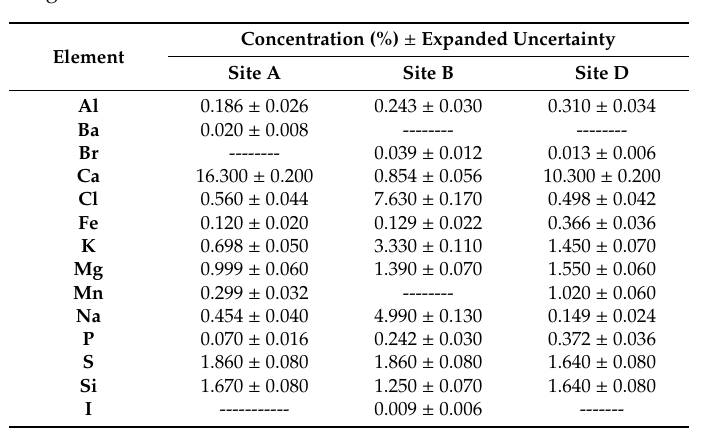
Table 2. Element concentrations ( ± measurement expanded uncertainty, expanded factor k = 2) determined in Ulva pilifera thalli using wavelength dispersive X-ray fluorescence (WDXRF) technique. Concentrations are given in %. The analysis were done only from sites A, B, and D while site C was below the limit of significance.